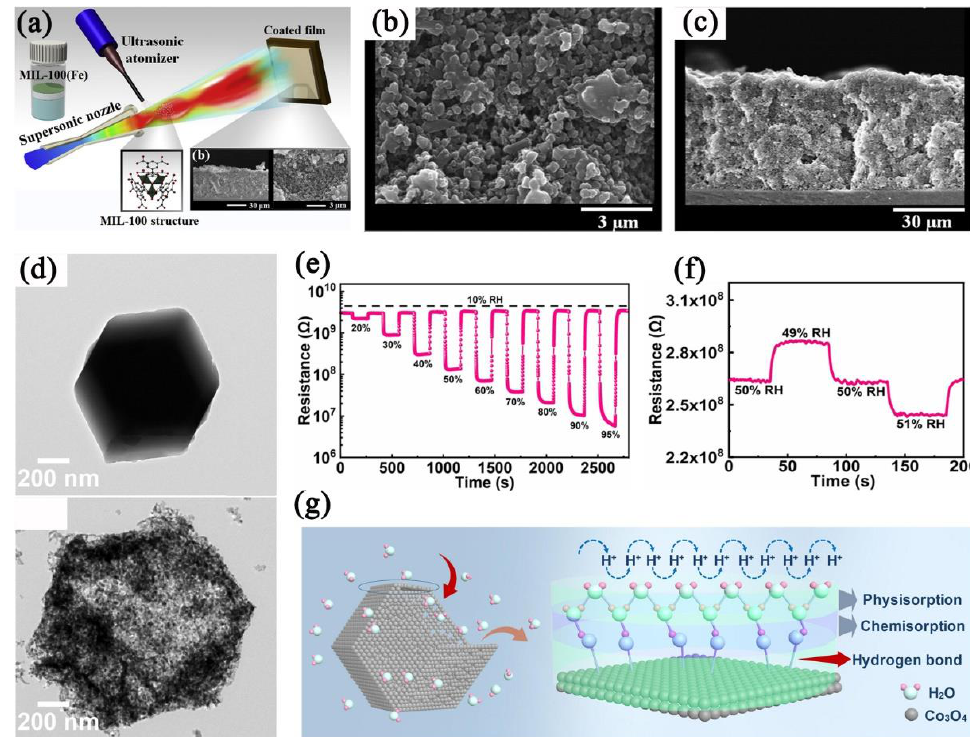
Figure 11. ( a ) Schematic illustration of cold − spray process showing the deposition of MIL − 100 film. ( b ) Enlarged surface morphology and ( c ) cross − section of the prepared MIL − 100 film. Reproduced with permission from Ref. [105]. Copyright 2017, Elsevier. ( d ) TEM images of ZIF − 67 − and ZIF − 67 − derived Co 3 O 4 . ( e ) Response curve of Co 3 O 4 − based humidity sensor to humidity in the range of 10 – 95% RH. ( f ) Response curve of Co 3 O 4 − based humidity sensor to 1% RH change. ( g ) Schematic diagram of continuous water films and proton conduction on the surface of Co 3 O 4 . Reproduced with permission from Ref. [55]. Copyright 2022, Elsevier.